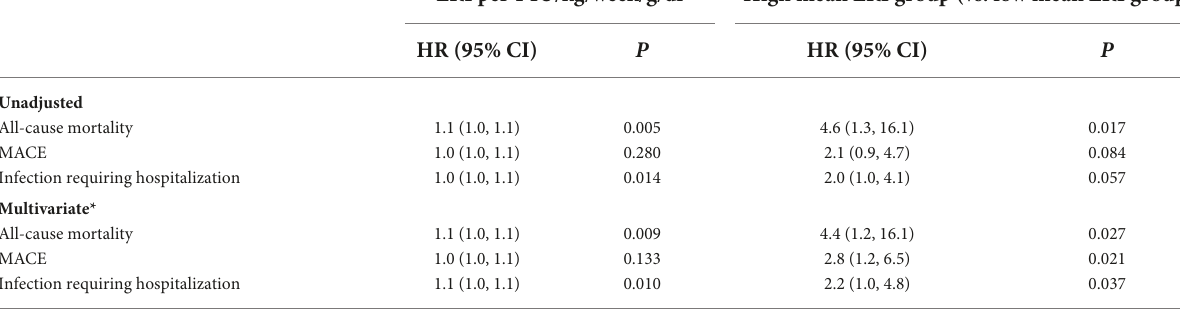
TABLE 2 Impacts of mean ERI on clinical outcomes during the study period. ERI per 1 IU/kg/week/g/dl High mean ERI group (vs. low mean ERI